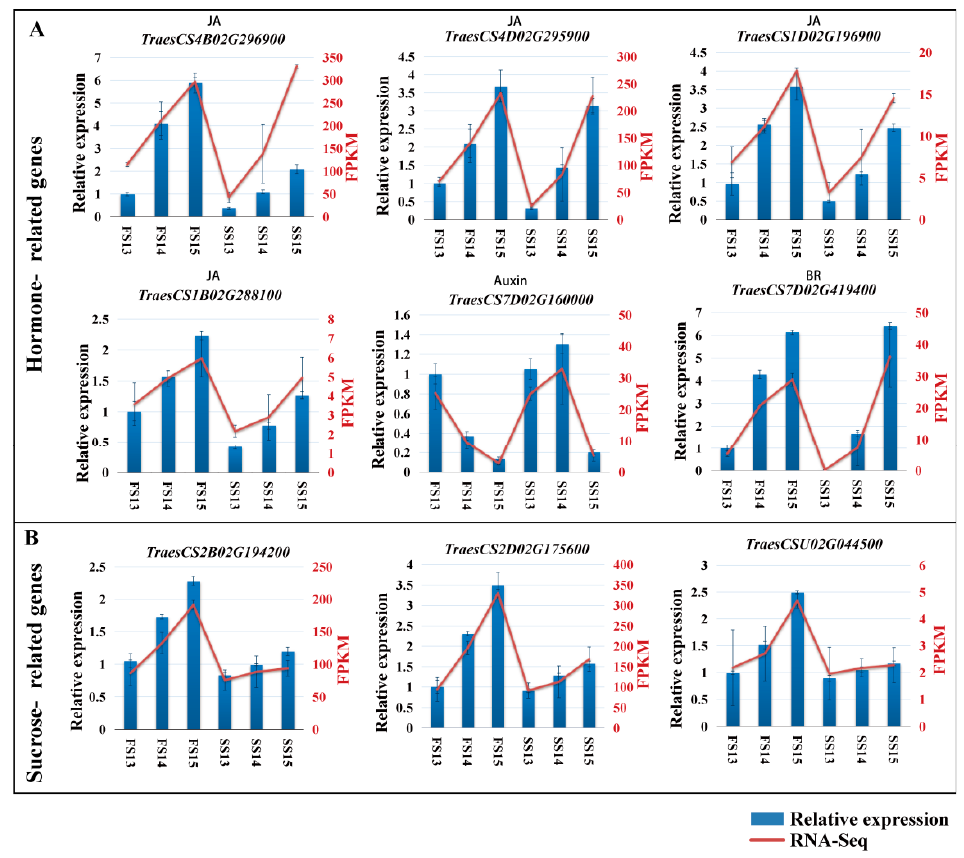
Figure 5. qRT-PCR analysis of the expression patterns of randomly selected hormone- ( A ) and sucrose ( B )-related DEGs.